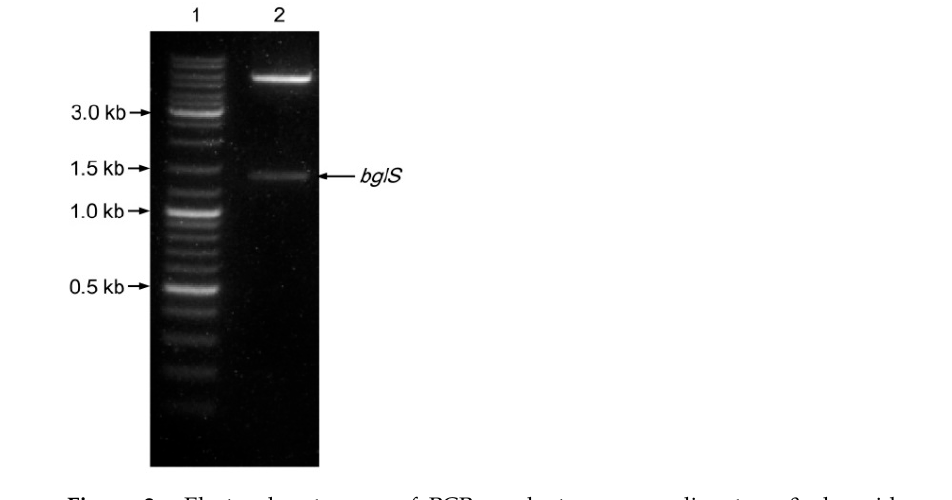
Figure 2. Electrophoretogram of PCR product corresponding to a β -glucosidase gene from Strepto- myces sp. RW-2. 1, DNA marker; 2, PCR product. Streptomyces sp. RW-2. 1, DNA marker; 2, PCR